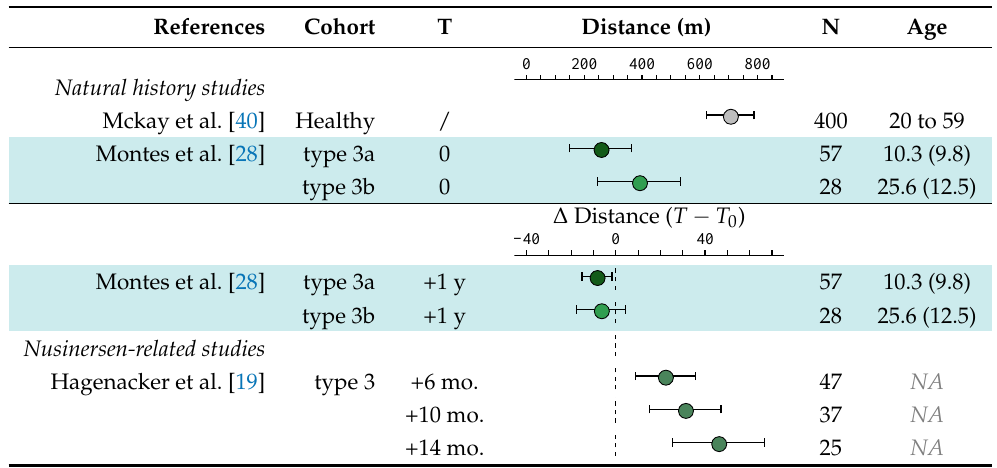
Table 4. Summary of representative results for the 6-Minute-Walk-Test (6MWT) by ambulatory patients. Graphical representation of the 6MWT in healthy and SMA patients from four independent studies. Columns are named as follows. References : bibliographic citations of the natural history or Nusinersen-related studies. Cohort : cohort composition in healthy and/or SMA patients with specified type or subtype when the information is available. T : time when the analysis was performed. Distance : distance reported in meters and represented as a boxplot; values are indicated as median ± standard deviation (s.d.). ∆ Distance ( T − T 0 ) indicates increment distance covered between the baseline before treatment ( T 0 ) and the final after treatment timepoint (T). N : number of patients included. Age : age of the subject in years as reported in the relative study (age range or mean (s.d.)); NA: not available. Colors of boxplot and dots are related to the cohort characteristics (SMA type or controls): gray: healthy subject; green: SMA type 3; dark green: SMA subtype 3a; light green: SMA subtype 3b. Background color associates consecutive table entries referring to the same